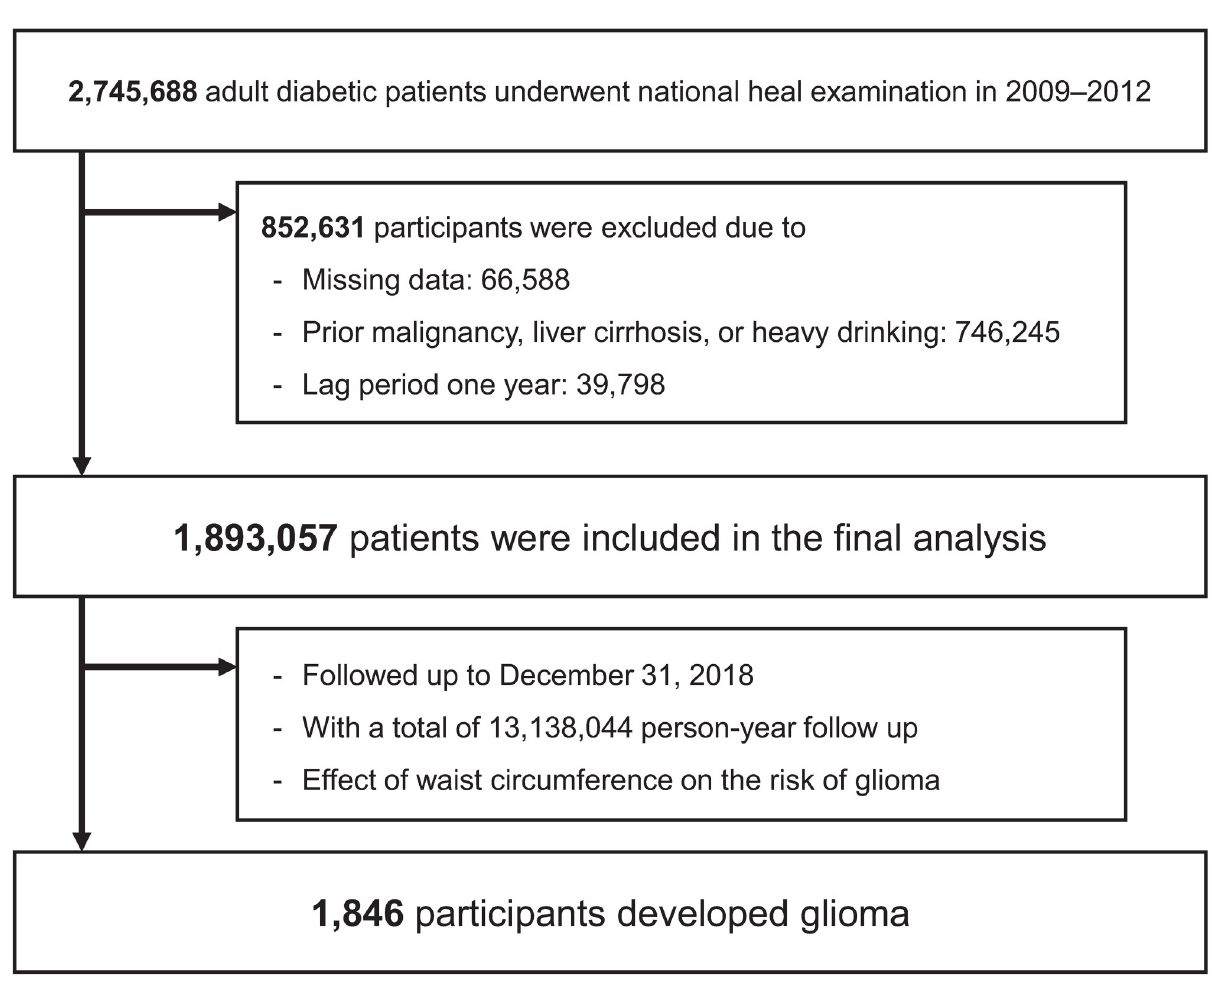
Fig 1. Study flowchart with data from the database of national health insurance